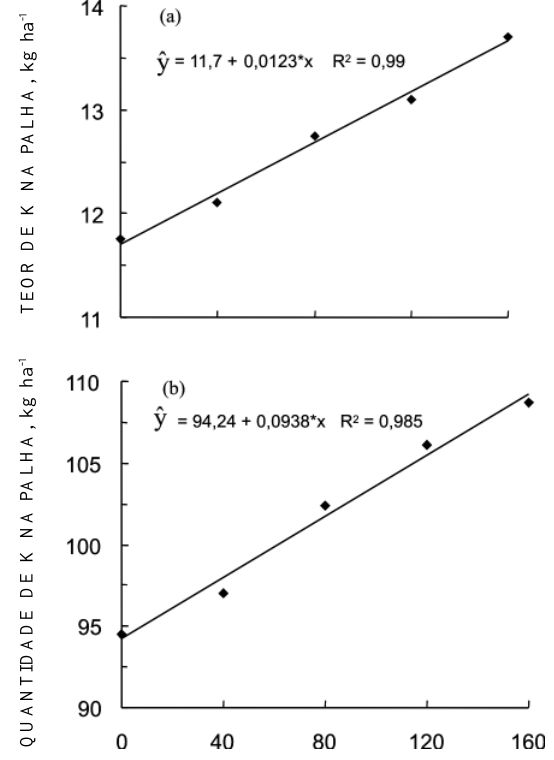
Figura 1. Teor e quantidade de K na palha (a) e (b) respectivamente, após a simulação de chuva nas diferentes doses de adubo potássico aplicadas em cobertura. * significativo a 5 %.